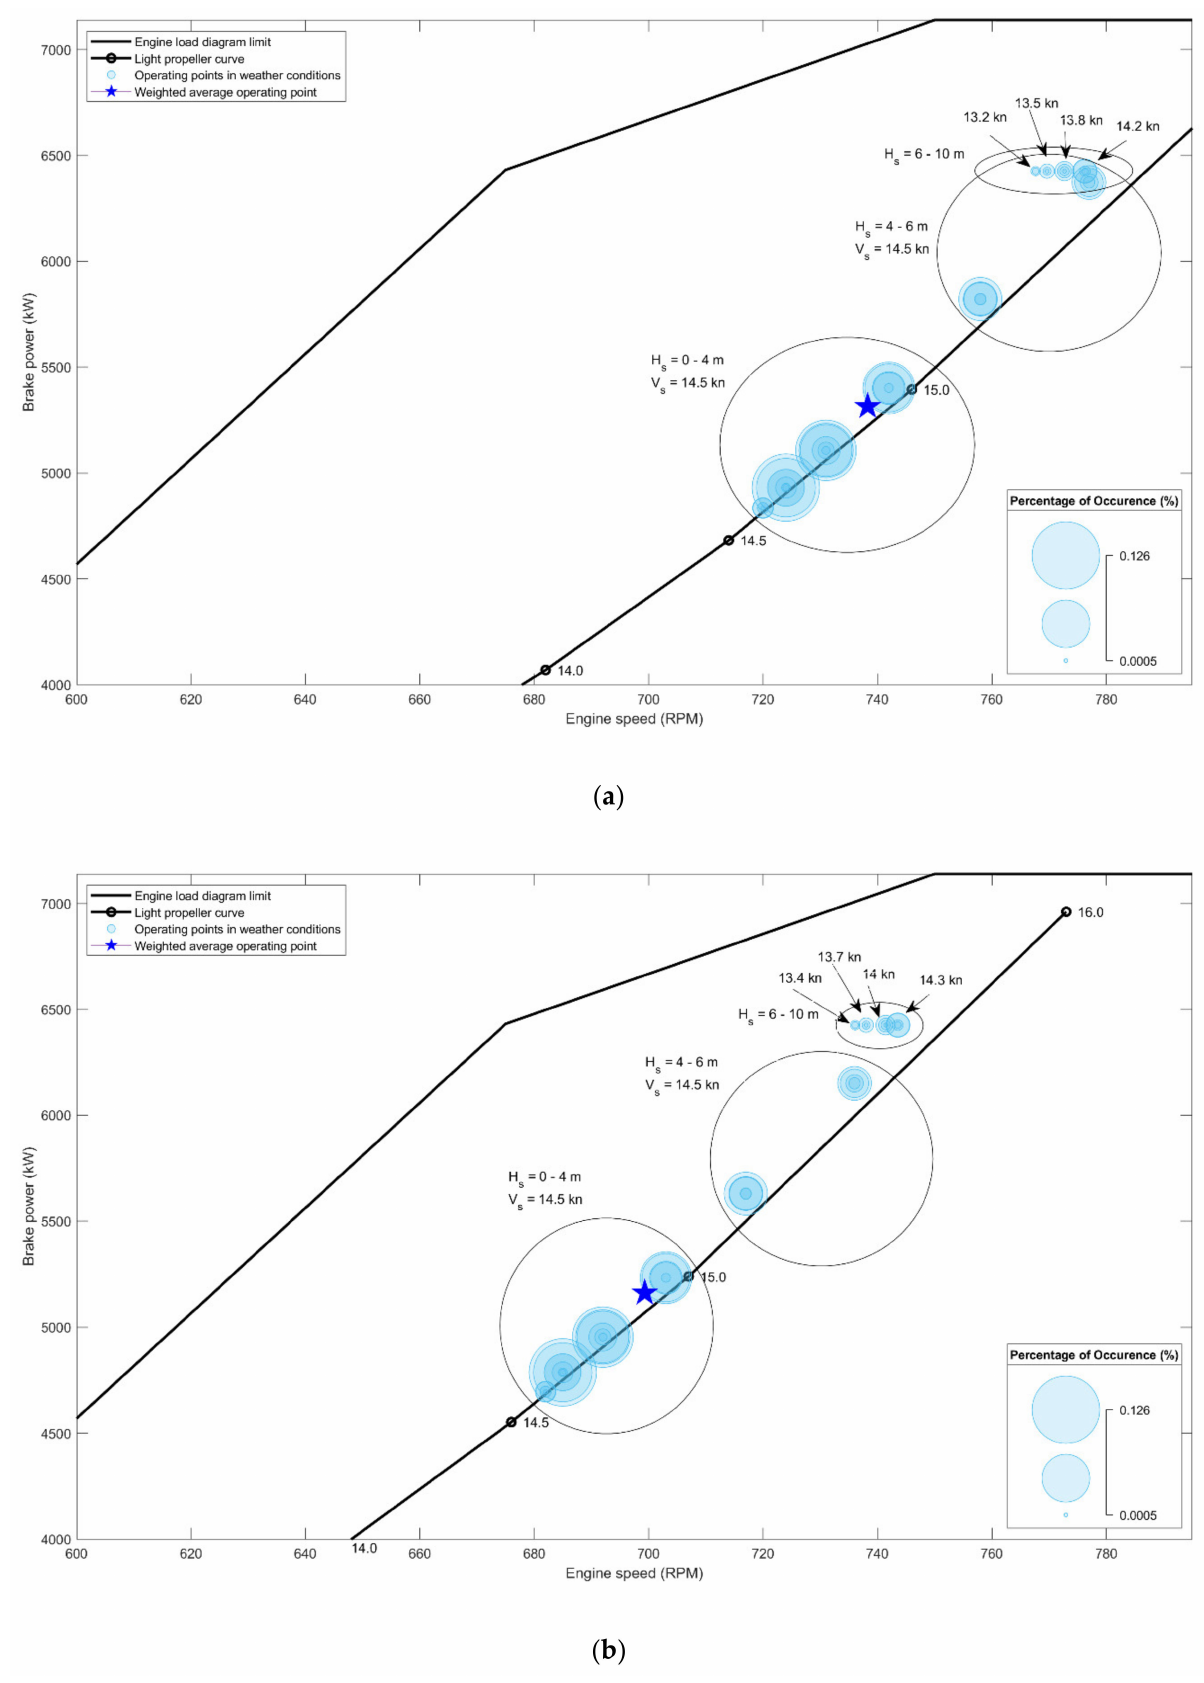
Figure 12. Propeller performance inside engine load diagram. ( a ) no cup, ( b ) heavy